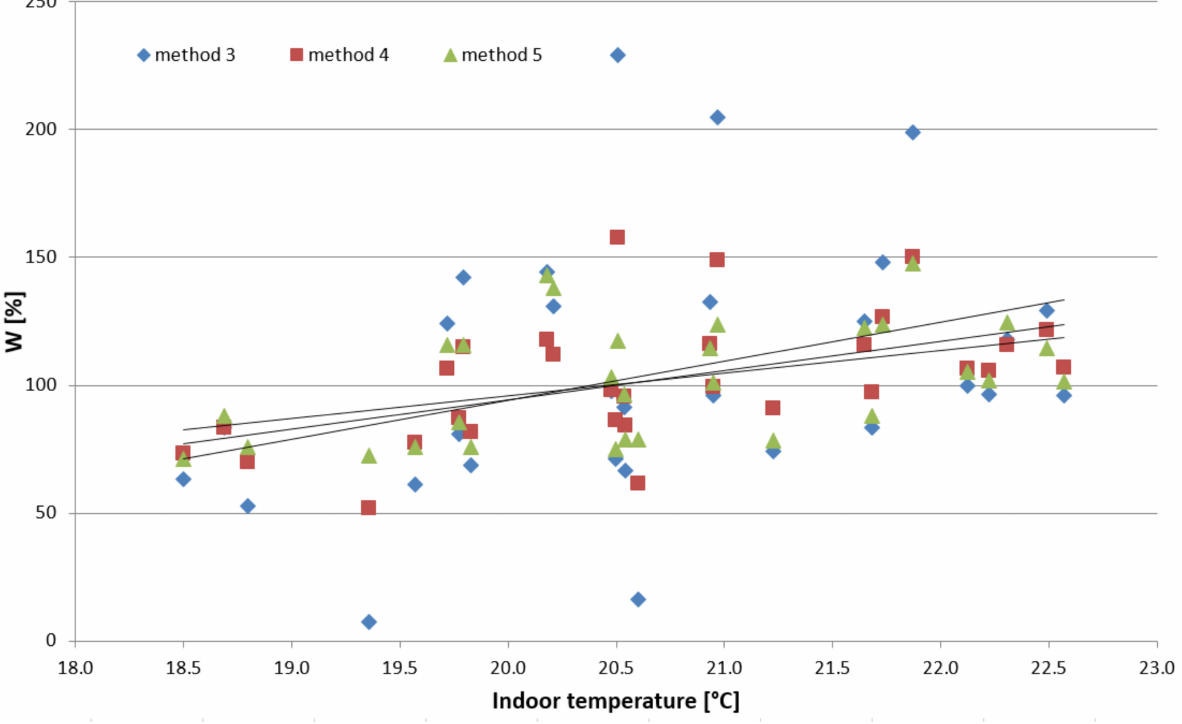
Figure 8. Correlation between the percentage distribution of individual heat costs in relation to the average value ( W ) for methods 3–5 and the indoor temperature of the